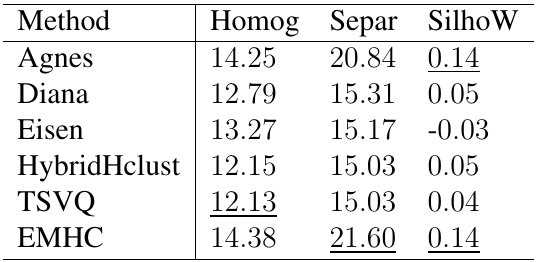
Table 2: Global cluster validity of EMHC vs. five hierarchical clustering methods from the lung data set.